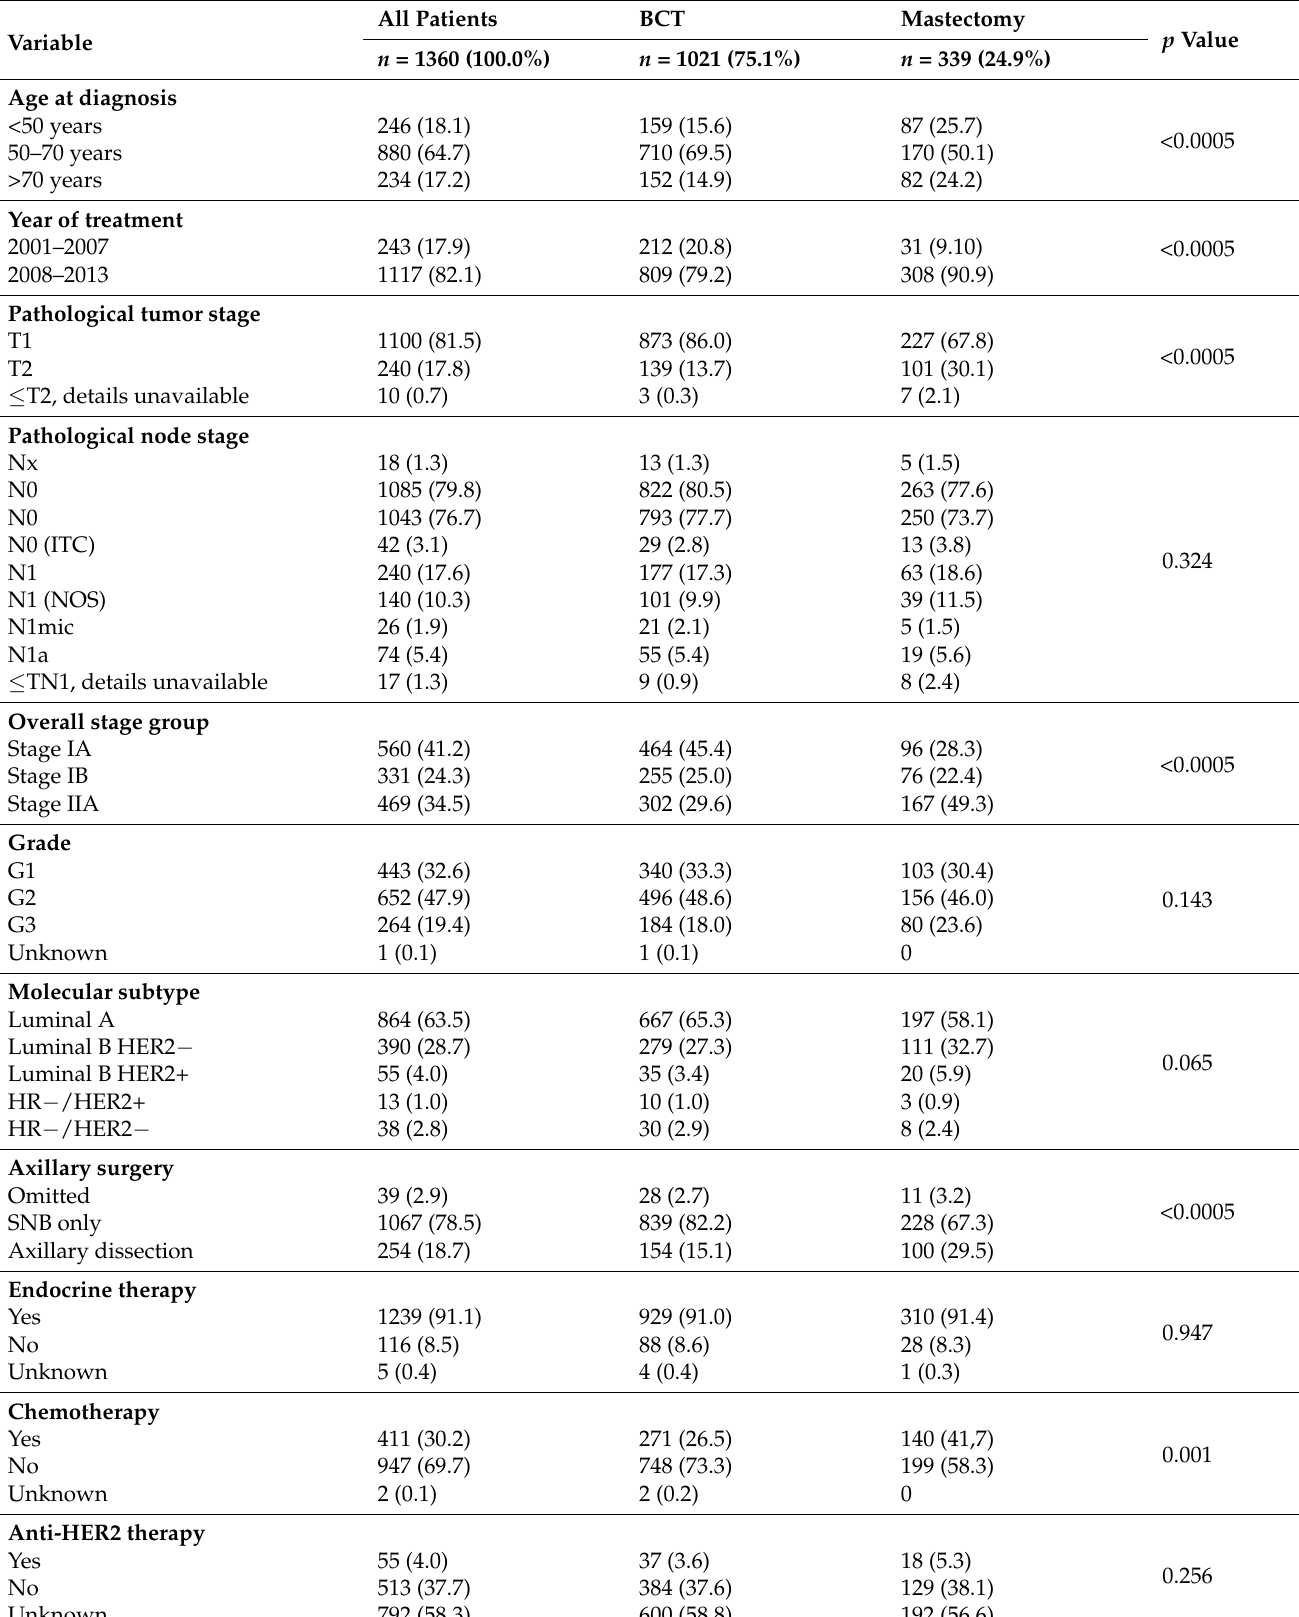
Table 1. Patients’ clinical, pathological, and treatment